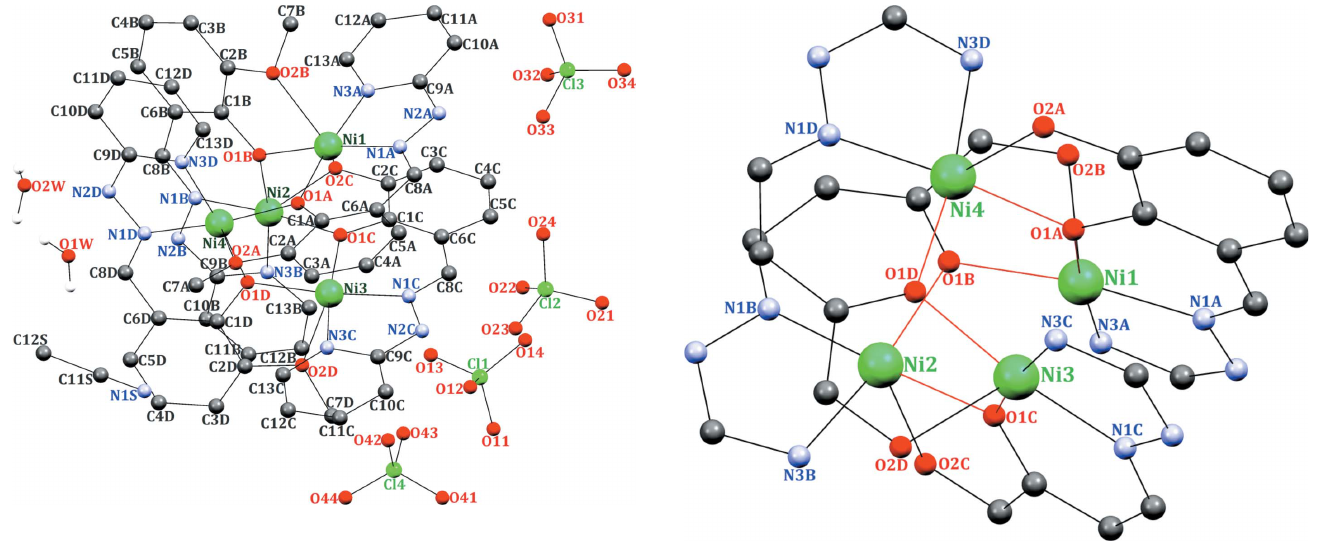
Figure 1 Molecular structure